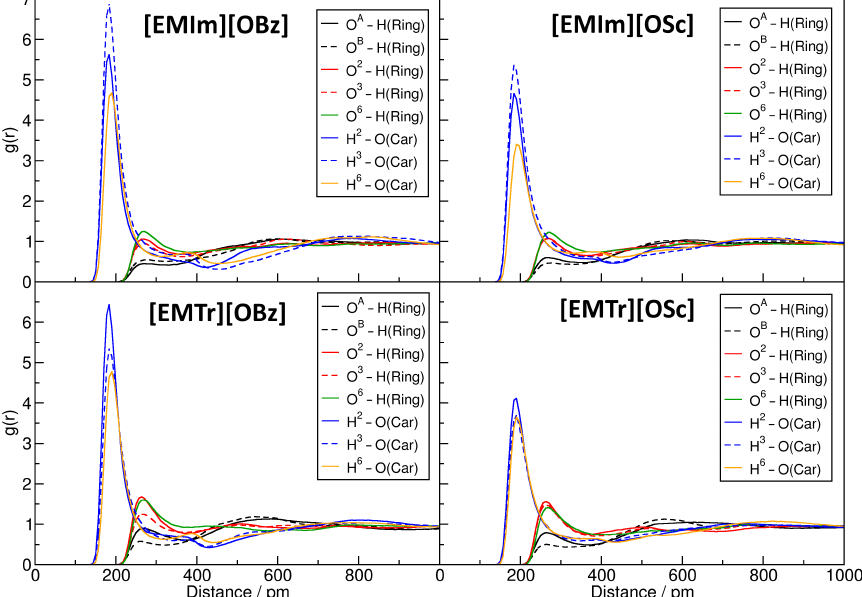
Figure 8. Radial distribution functions (RDFs) for the hydrogen bonds between cellulose and the anions and cations in the four systems. For atom labels, see Figure 1. For the oxygen atoms of cellulose, larger differences are visible. The hydrogen bond acceptors O 2 , O 3 , and O 6 form relatively strong hydrogen bonds to the cations’ ring protons, which are